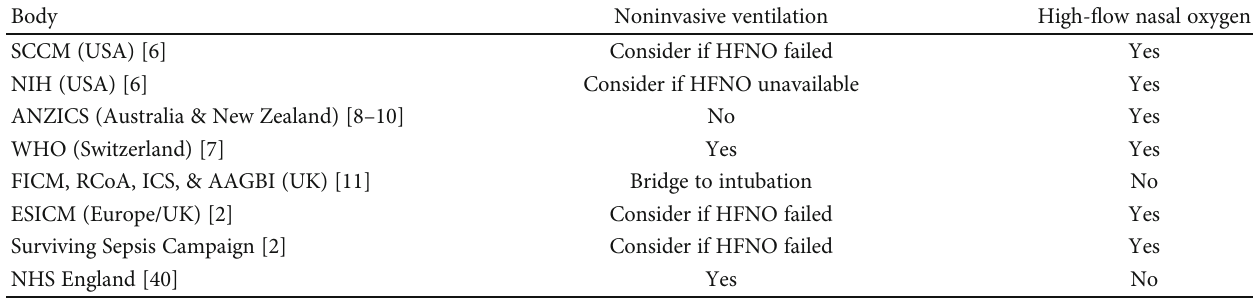
Table 1: A comparison of major organisation recommendations for CPAP/NIV and